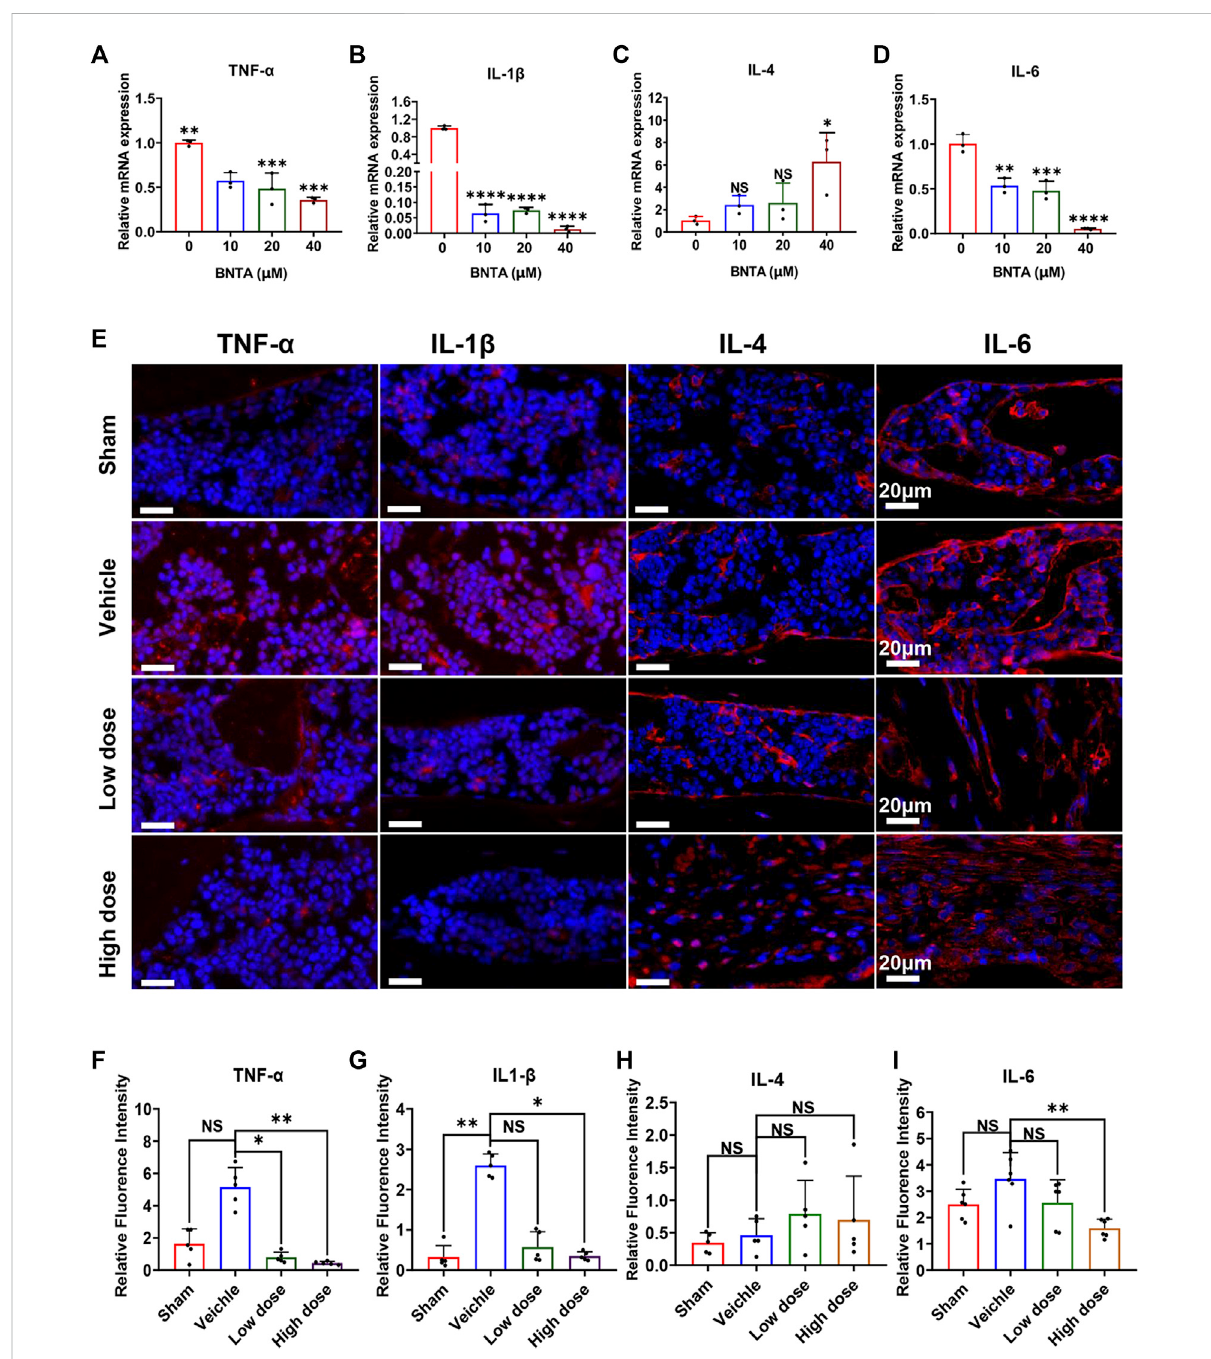
BNTA regulated in fl ammation-related gene expression. (A – D) qPCR analysis of in fl ammation-related genes expression of TNF- α , IL1- β , IL-4, and IL-6 relative to GAPDH in BMMs stimulated by RANKL for 5 days with or without an indicated dose of BNTA ( n = 3 per group). All data are presented as mean ± SD. * p < 0.05, ** p < 0.01, *** p < 0.001, **** p < 0.0001 compared with control group. (E) Representative immuno fl uorescence staining images of decalci fi ed bone sections for protein expression of TNF- α , IL1- β , IL-4, and IL-6. (F – I) Quantitative analysis of